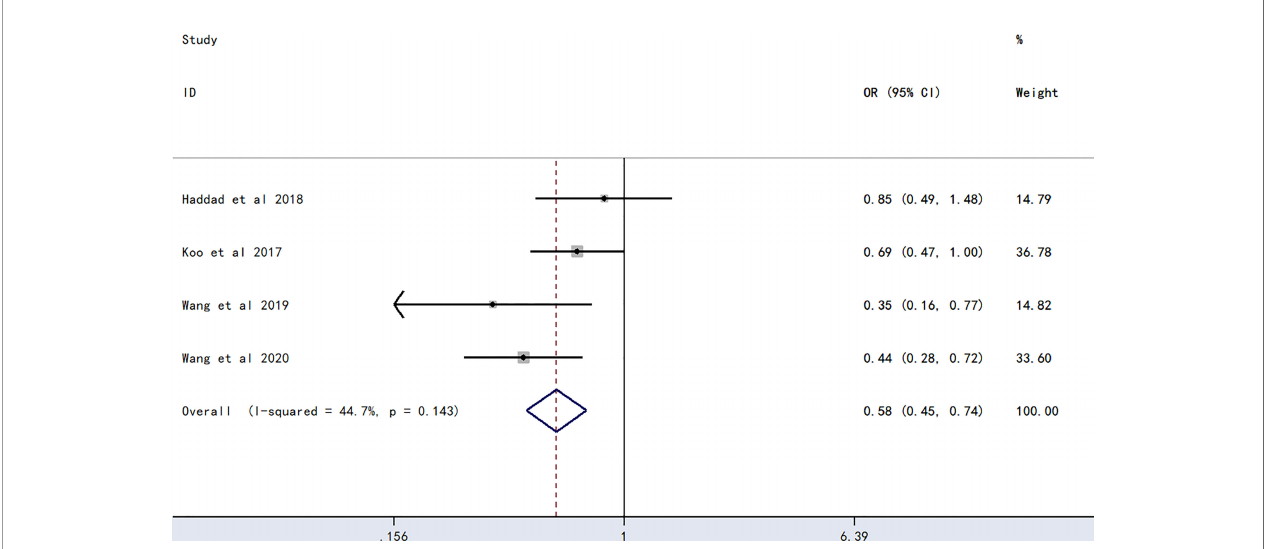
FIGURE 2 | Forest plot evaluating the association between PICC-associated VTE and the prevalence of O blood